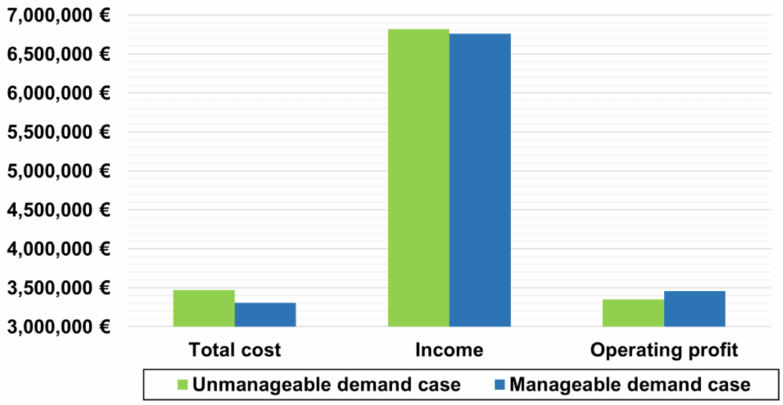
Figure 6. Evolution of annual costs and income of the case studies.